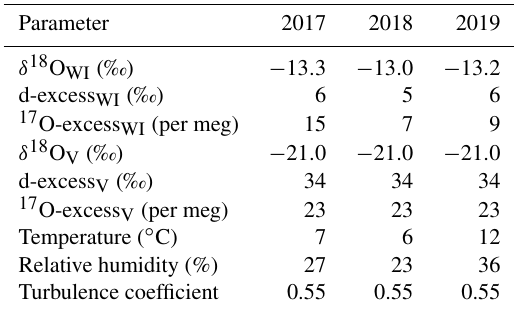
Table 3. Model input parameters of the simple and the recharge evaporation model for natural ponds and lakes from the Salar del Huasco. The isotopic composition of inflowing water ( δ WI ) was inferred from the spring with the most depleted δ 18 O value. The isotopic composition of atmospheric vapour ( δ V ) was estimated by direct measurement. Evaporation trajectories were modelled with temperature and relative humidity values averaged over 10d (March 2019) or 20d (September 2017, September 2018) prior to sampling (Fig. 4), corresponding to the mean seasonal isotopic “turnover time” (cf. Sect. 6.1). Diurnal variations in the evaporation rate were accounted for using daytime (06:00–18:00CLT)